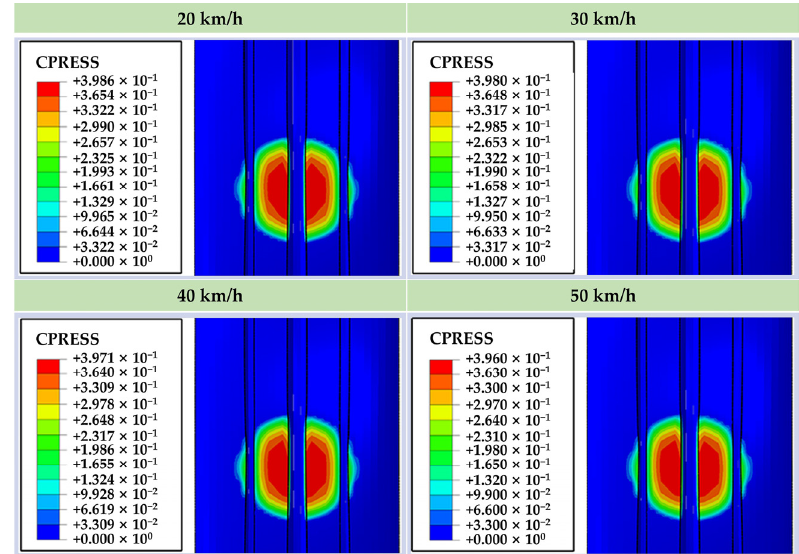
Figure 17. Contour map of tire contact pressure at different speeds.